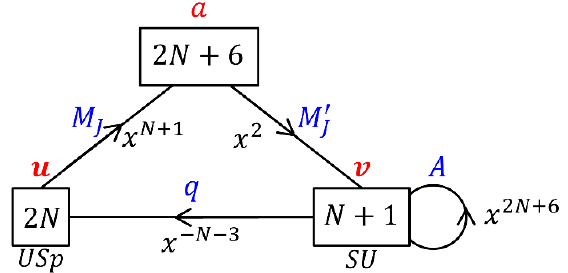
Figure 12 . A quiver diagram of the (cid:13)ux tube with one USp(2 N ) maximal puncture and one SU( N + 1) maximal puncture and 1 = 4 (cid:13)ux for U(1) x embedded in SO(4 N + 12) as SO(4 N + 12) ! U(1) x (cid:2) SU(2 N + 6). The 2 N square denotes the USp(2 N ) symmetry of one maximal puncture, the N +1 square denotes the SU( N +1) symmetry of the second maximal puncture and the 2 N +6 square denotes an SU(2 N + 6) symmetry. the SU(2 N + 6) a symmetry together with U(1) x are related to the internal symmetries coming from 6 d . The operators M and M 0 have R-charge 1, q has R-charge 0 and A has an R-charge 2. In blue we write the (cid:12)eld names, in red we write the fugacities associated to puncture and gauge symmetries, and in black we write the fugacities of each (cid:12)eld. The closed loop of (cid:12)elds has a superpotential term turned on for